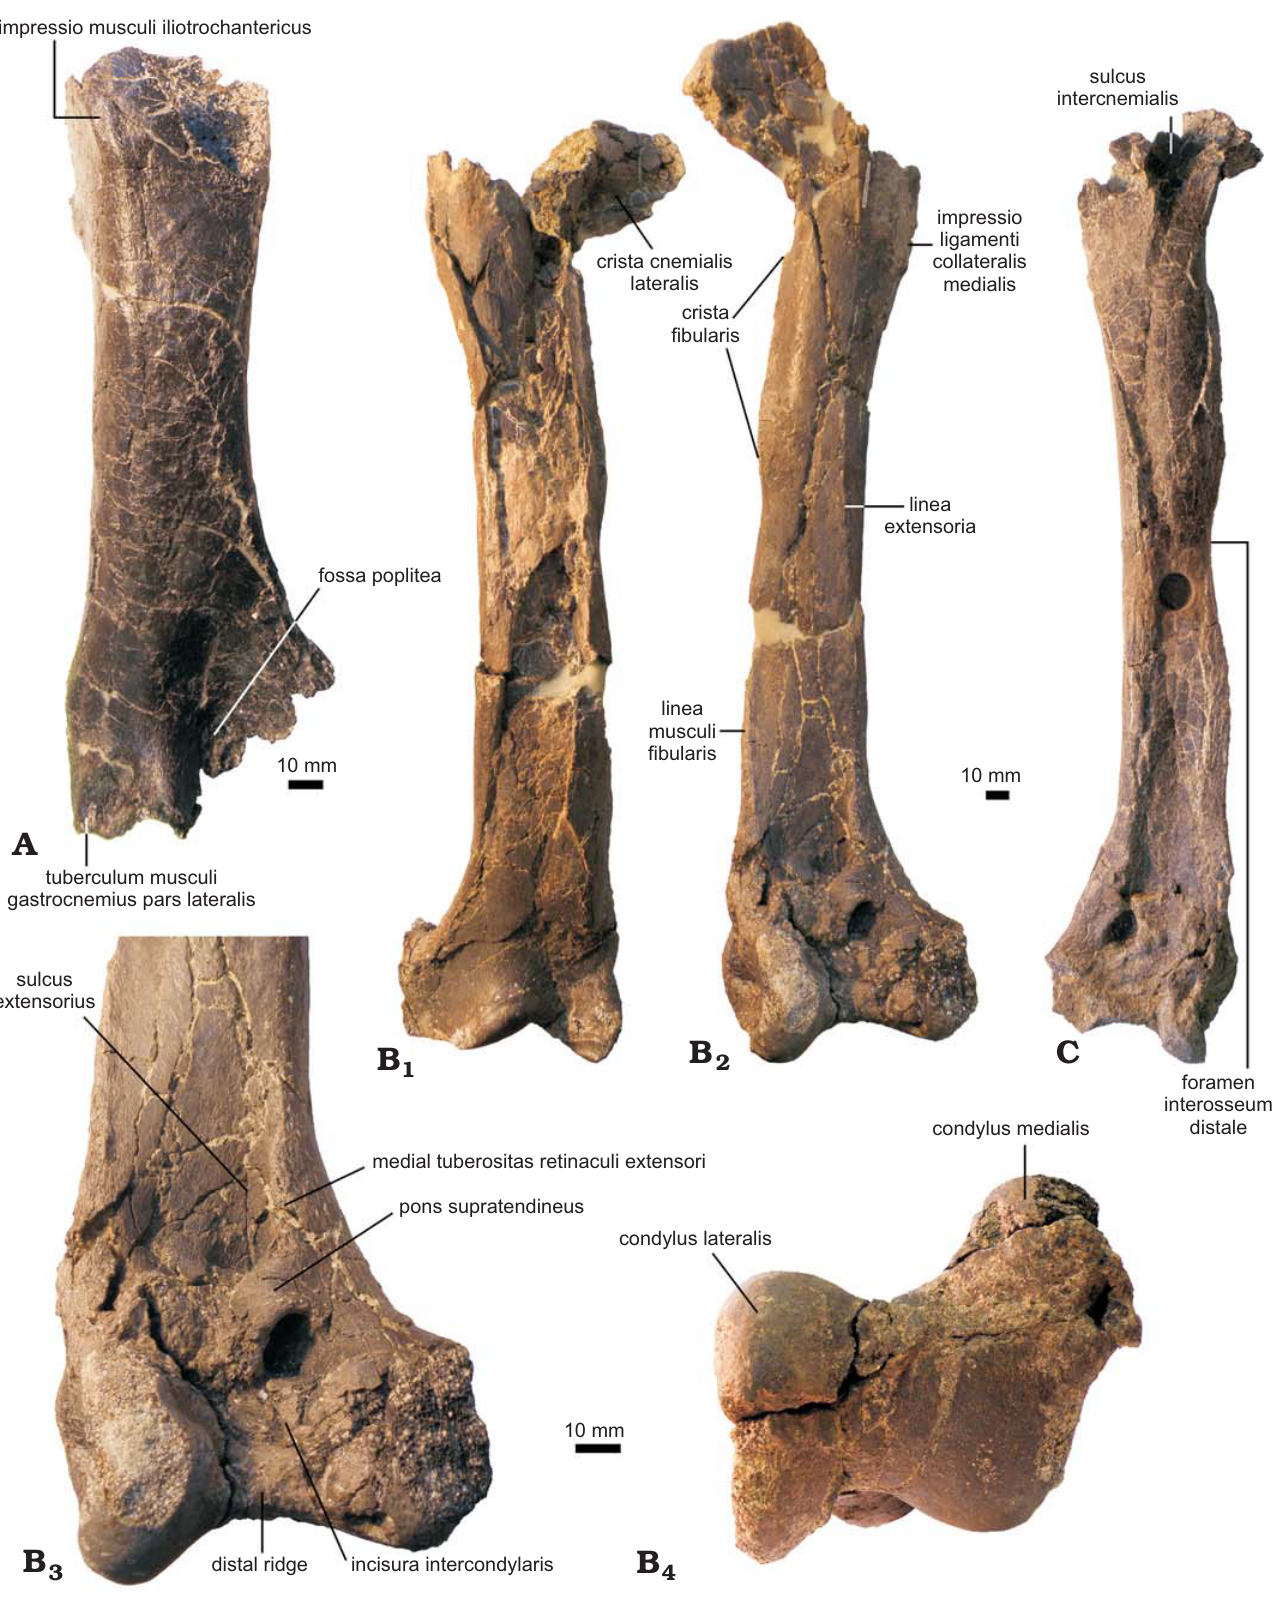
Fig. 4. Hindlimb of gastornithid bird Gastornis parisiensis Hébert, 1855, early Eocene, La Borie, France. A . Left femur MHNT.PAL.2013.15.9, in caudal view. B . Right tibiotarsus APSO.2006.SP1-62, in caudal (B MHNT.PAL.2013.15.10, in cranial